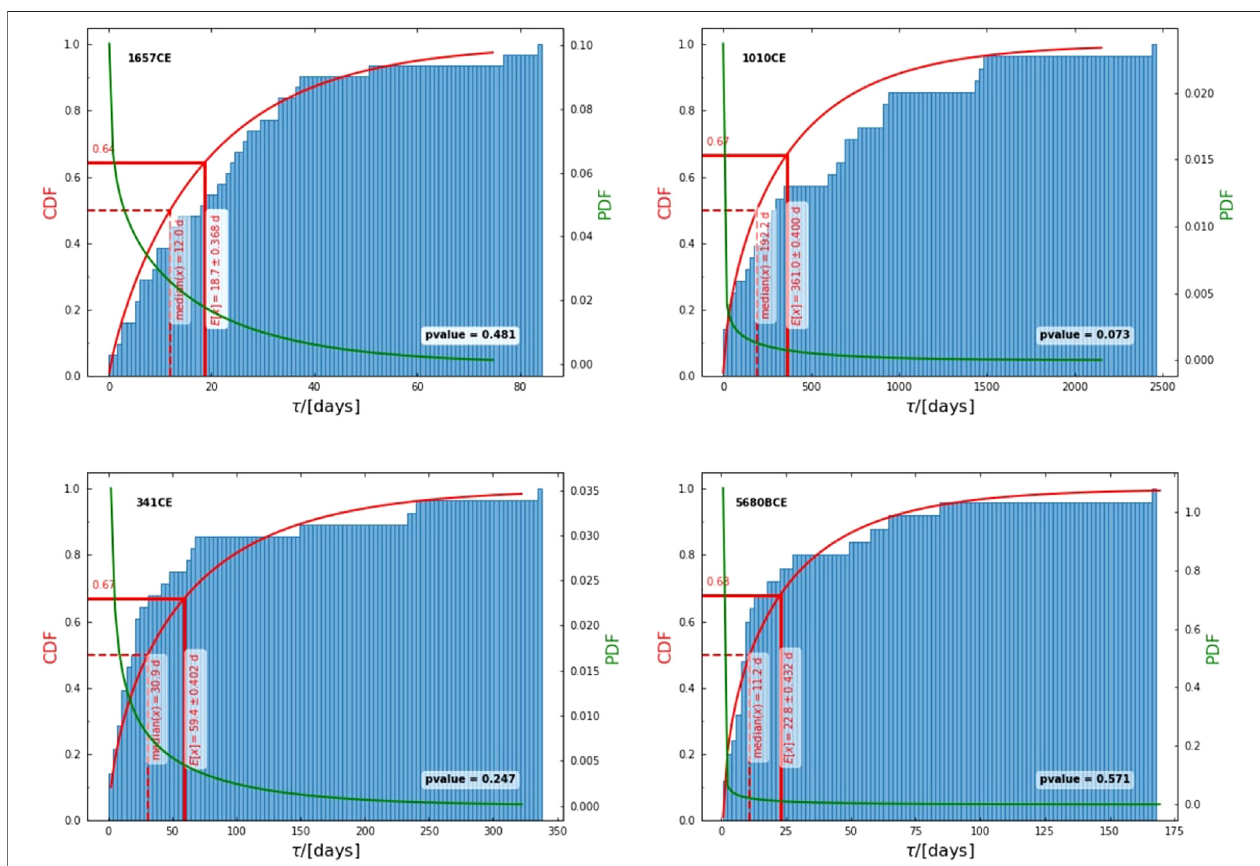
FIGURE 9 | Distribution of timescales for the 1657 Cal. CE, 1010 Cal. CE, ∼ 341 Cal CE and 5680 Cal. BCE eruptions. Blue bars indicate the empirical cumulative density frequencies (CDF), red curves indicate the theoretical distributions fi tted to these and the green curves represent the theoretical probability density frequencies. On each plot we indicate the mean and median timescales predicted by the theoretical distributions and the p -values (goodness-of- fi t) between model and data.